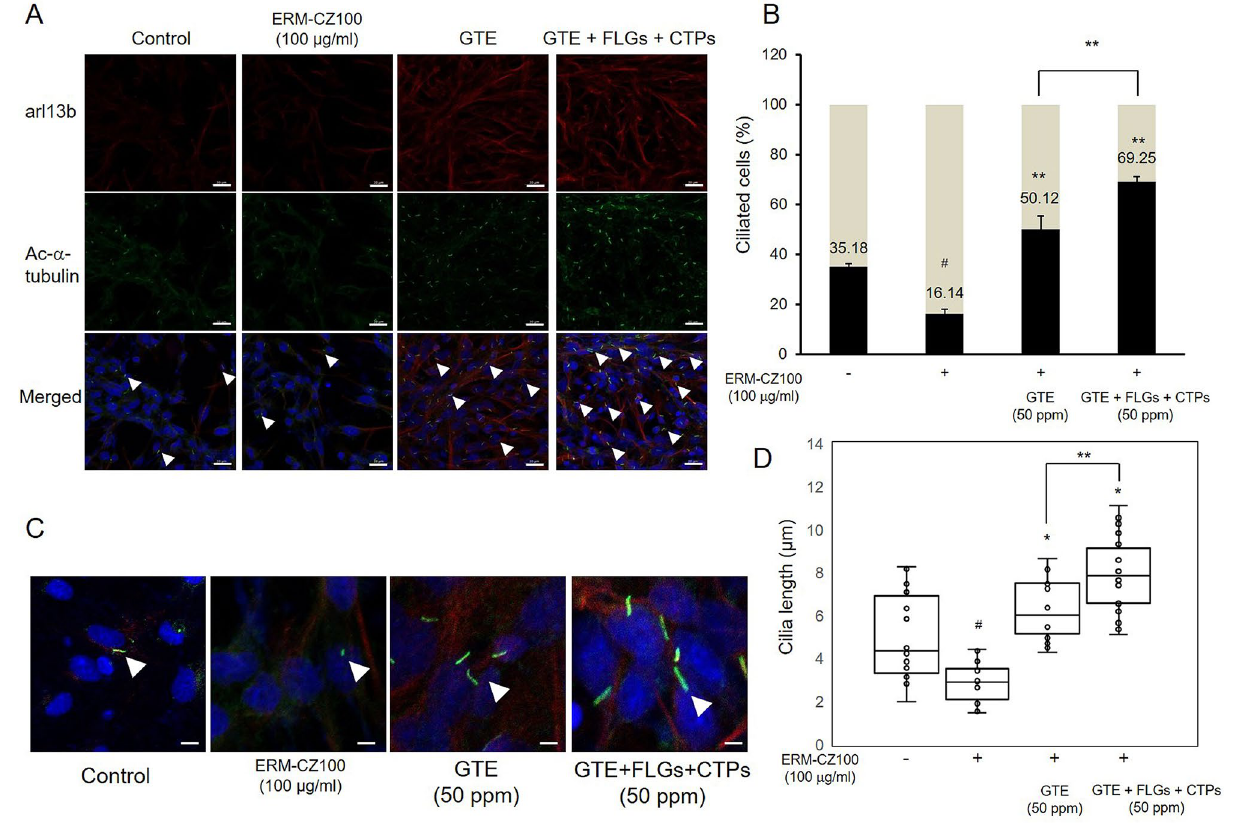
Figure 6. Ameliorative effects of GTE, FLGs, and CTPs on FDP-induced ciliogenesis suppression in BEAS-2B cells. ( A ) Immunostaining of cilia in FDP-stimulated BEAS-2B cells. ( B ) Ciliated cells were counted, and the results are presented as the proportions of ciliated cells among all cells. ( C ) Activation of ciliogenesis by GTE, FLG, and CTP treatment. ( D ) Cilia length of ciliated cells. Boxplot the median with upper and lower quartiles, all data points have been plotted. Data have a minimum of 17 cilia per condition, from a total of between 3 and 6 experiments. The data are presented as the mean ± SD (N = 3). * p < 0.05 compared to the FDP-treated group; ** p < 0.001 compared to combined treatment with GTE; # p < 0.001 compared to the vehicle control group. The ciliated cells were immunostained for ARL13B (red) and acetylated-α-tubulin (green), and merged fluorescence is indicated with DAPI (blue). Scale bars, 20 μm in A and 5 μm in ( C